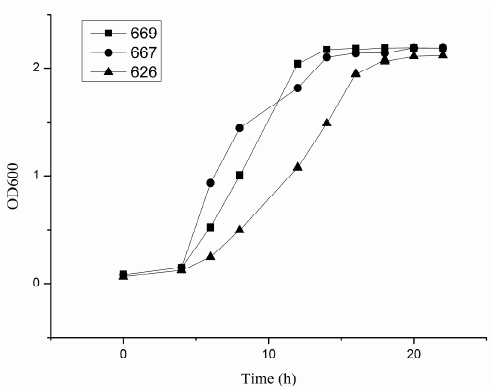
Figure 1. Growth curves of three strains of Bifidobacterium adolescentis . The horizontal axis is the time of culturing B. adolescentis , and the vertical axis is the absorbance value of the culture solution at 600 nm: 669, the growth curve of B. adolescentis 669; 667, the growth curve of B. adolescentis 667; and 626, the growth curve of B. adolescentis 626. The curves shown are from a single experiment (mean ± SD, n = 3).